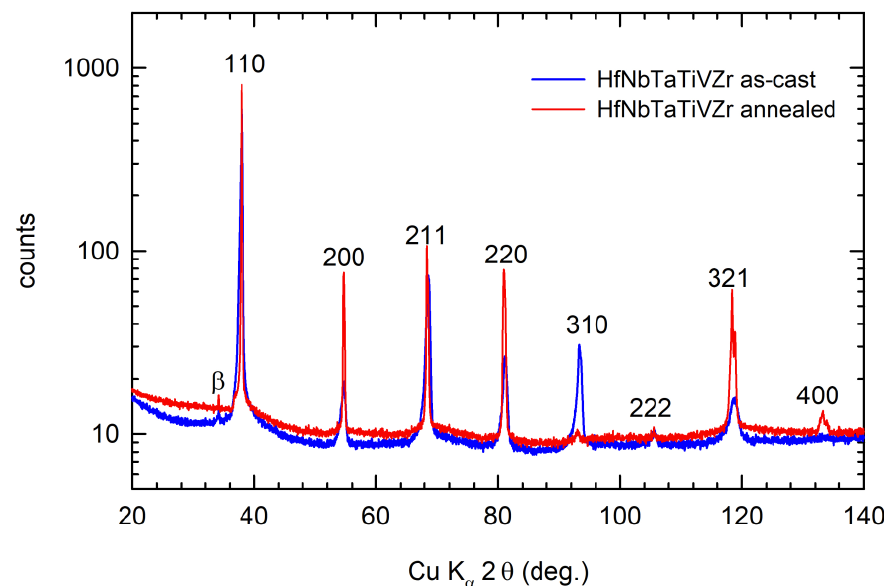
Figure 18. XRD pattern of HfNbTaTiVZr alloy in the as-cast state and after annealing at 1200 °C. The label β denotes reflection arising from the Cu K β wavelength.